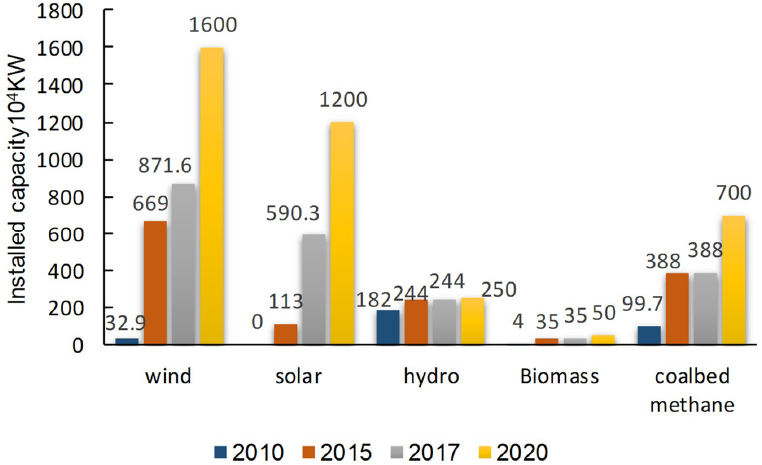
Figure 3. Installed electricity capacity by source in the Province of Shanxi (2017).